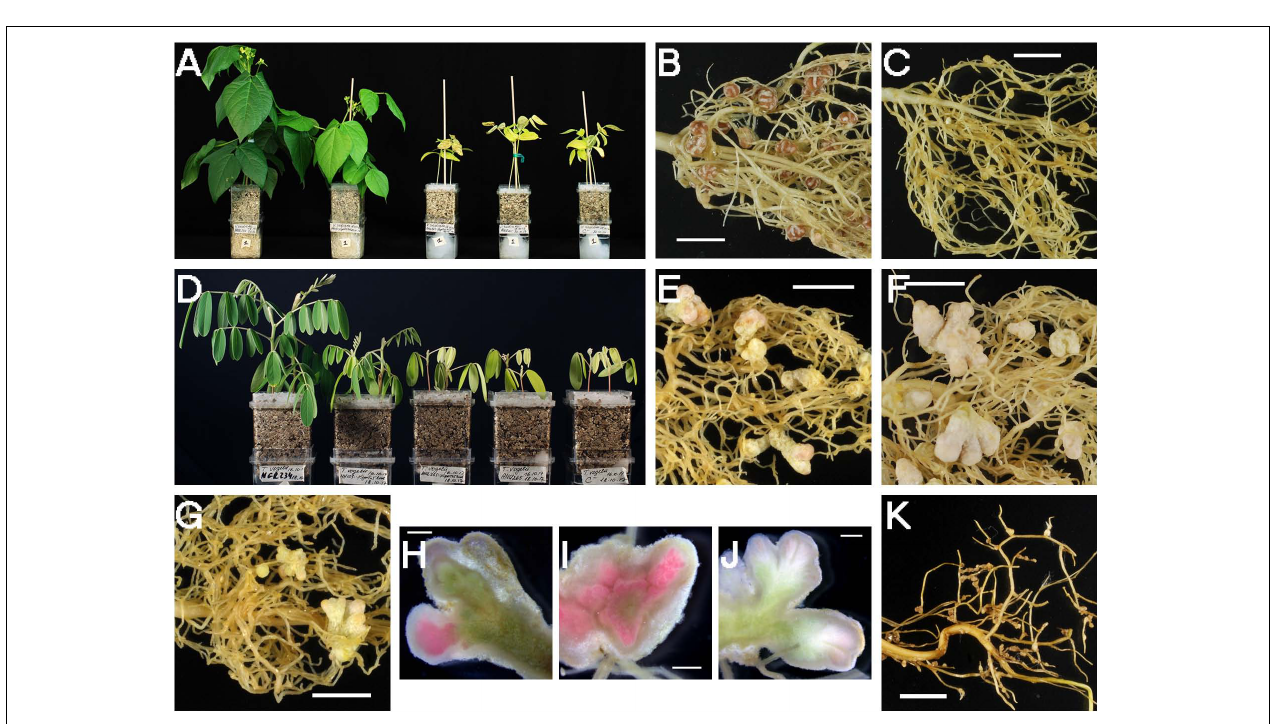
FIGURE 6 | Plant responses of three host legumes of S. fredii NGR234, Vigna radiata (A–C) , Tephrosia vogelii (D–J) and Leucaena leucocephala (K) , with different S. fredii strains. (A) Phenotypes of strains on mung bean ( V. radiata ) at 42 dpi. From left to right, plants inoculated with NGR234, HH103-M, NGR234C pSymHH103M, NGR234C, and uninoculated control. (B) Nodules induced by HH103-M in V. radiata roots (42 dpi). (C) Pseudonodules induced by NGR234C pSymHH103M in V. radiata roots (42 dpi). (D) Phenotypes of strains on T. vogelii at 58 dpi. From left to right, plants inoculated with NGR234, HH103-M, NGR234C pSymHH103M, NGR234C, and uninoculated controls. (E–J) Nodules induced by HH103-M (E,H) , NGR234 (F,I) , and NGR234C pSymHH103M (G,J) in T. vogelii roots (58 dpi). (K) Abnormal root outgrowths on L. leucocephala 81 dpi with NGR234C pSymHH103M. Bars correspond to 1 cm in (B,C,E–G,K) , and 1 mm in (H–J)